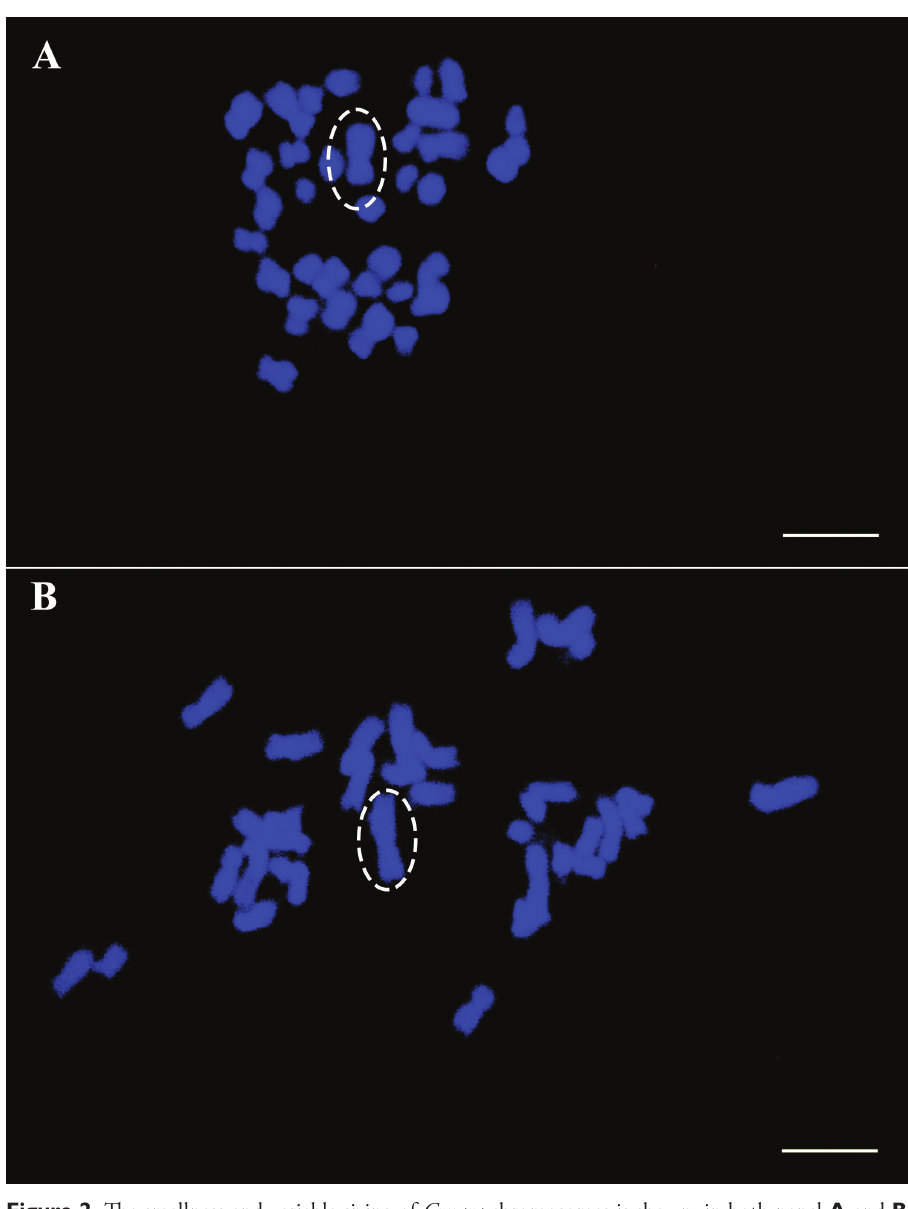
Figure 2. The smallness and variable sizing of Cynara chromosomes is shown; in both panel A and B , leafy cardoon chromosome 1 has been circled as an example of the different condensation level of the same metaphase chromosomes. In A chromosome 1 is 3.2 µm, in B it is 4.3 µm (a 36% size variation). Scale bars: 5